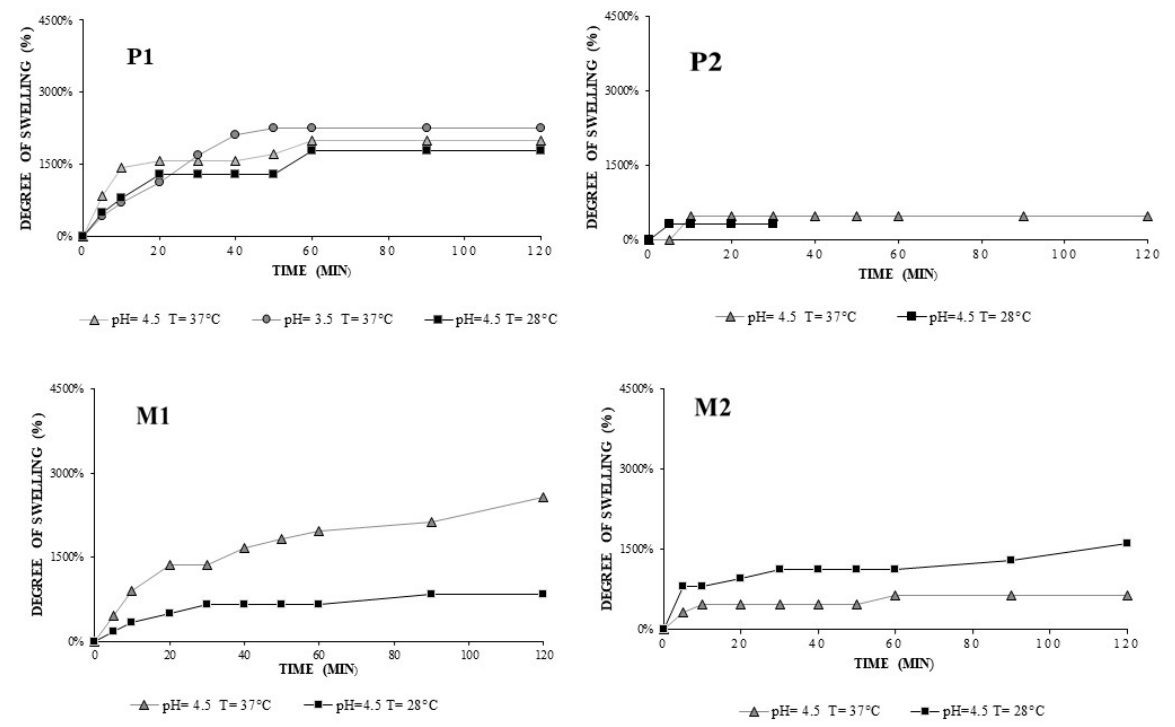
Figure 7. Swelling profiles at pH 4.5 and different temperatures for P1/M1 and P2/M2 hydrogels. Hydrogel P3 allowed the degree of swelling to be determined at all three pHs in Figure 8. The degree of crosslinking influences the solubility of the hydrogel; P3 is more resistant in the acid environment compared to P1 and P2, because of a larger amount of crosslinking agent.